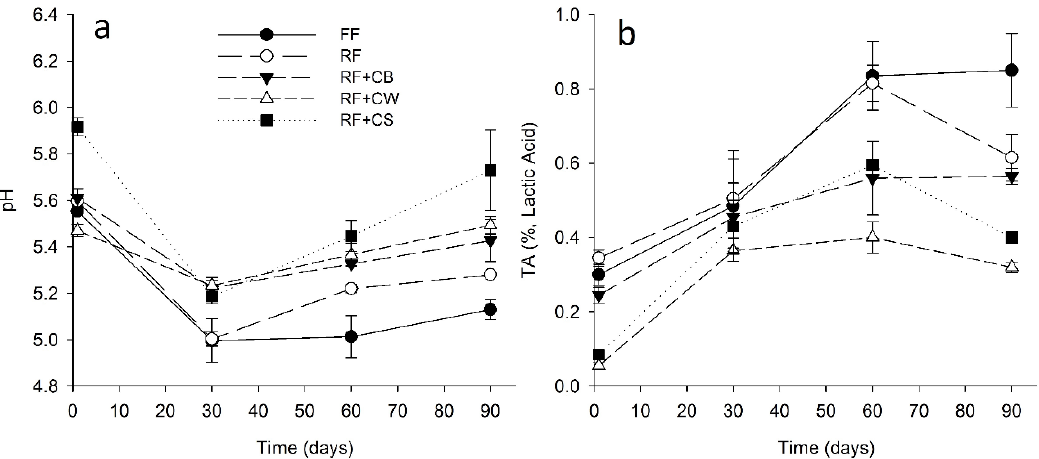
Figure 4. ( a ) pH and ( b ) titratable acidity (TA) of tested cheeses over ripening. (FF): full-fat; (RF): reduced-fat; (RF + CB): reduced-fat with concentrated buttermilk; (RF + CW): reduced-fat with concentrated whey; (RF + CS): reduced-fat with concentrated second cheese whey.